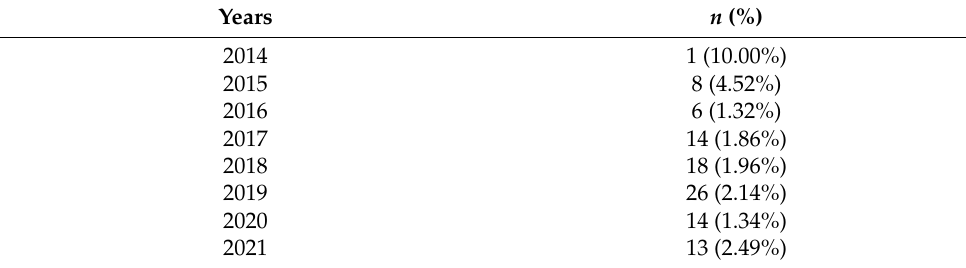
Table 8. Failed procedure according to year from initiation onwards.